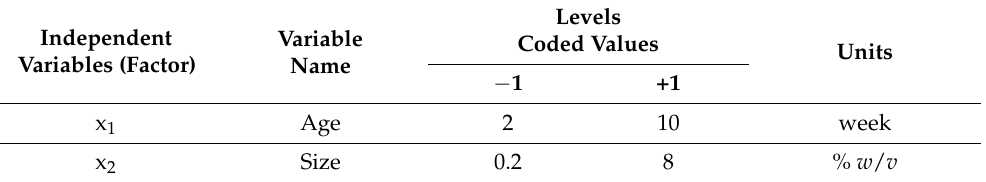
Table 5. Factors and levels of response surface method (RSM) analysis. Independent Variables (Factor)